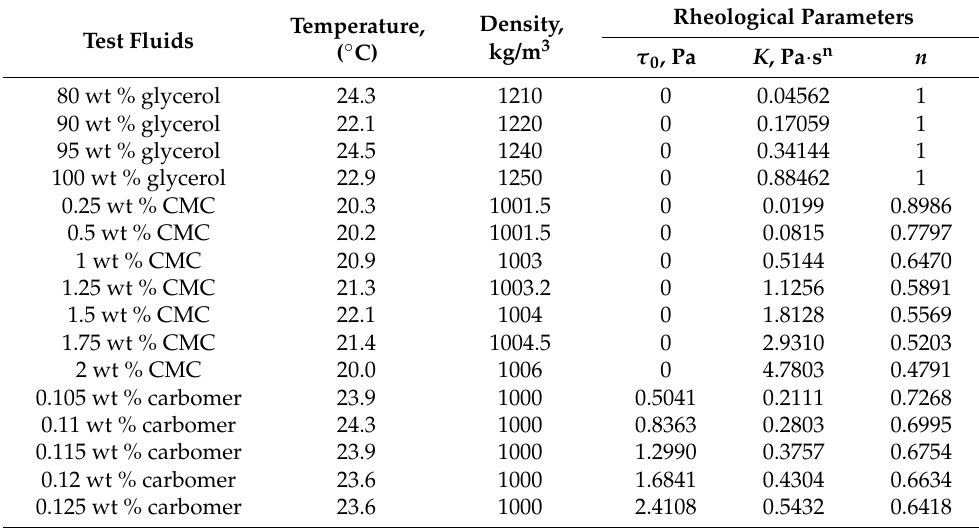
Table 2. Rheological parameters of different